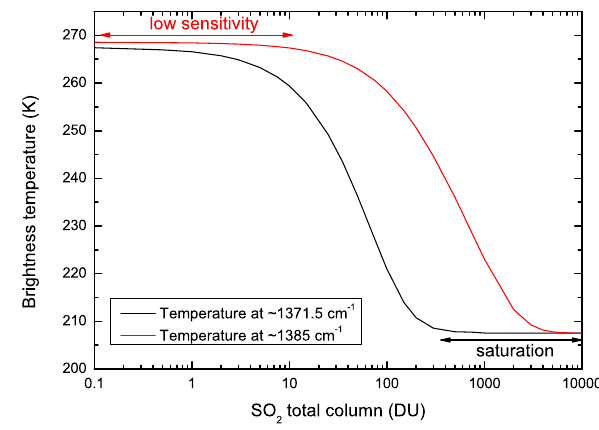
Fig. 3. Brightness temperature of the two sets of absorption chan- nels (at ∼ 1371.5cm − 1 and at ∼ 1385cm − 1 ) as a function of SO 2 abundance for a plume located at 150hPa and